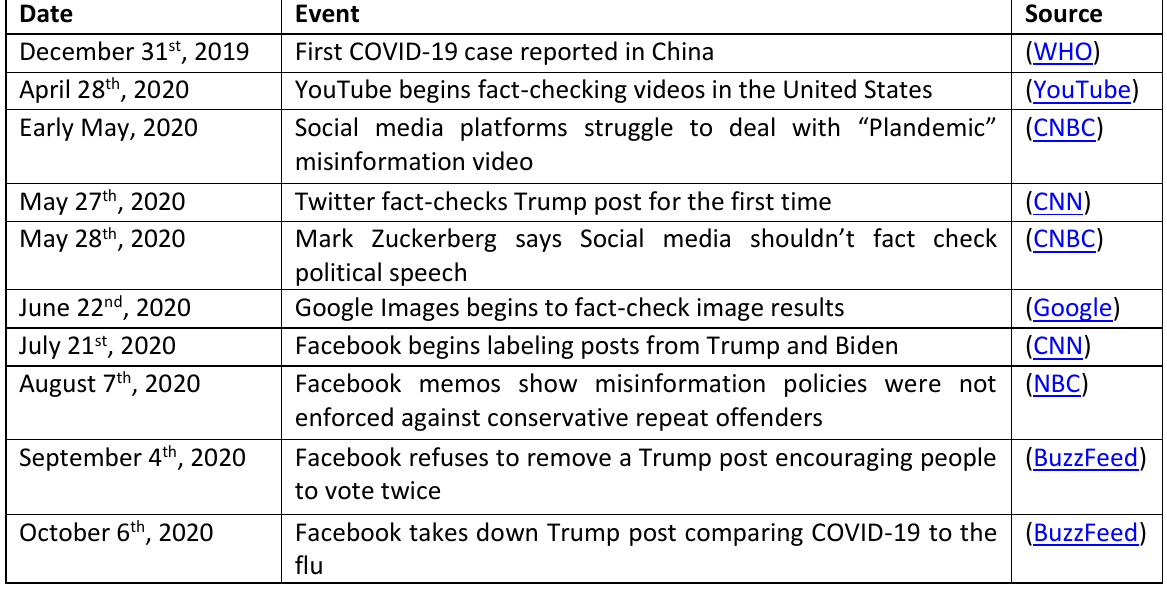
Table 1. Summary of key fact-checking events during the COVID-19 crisis.